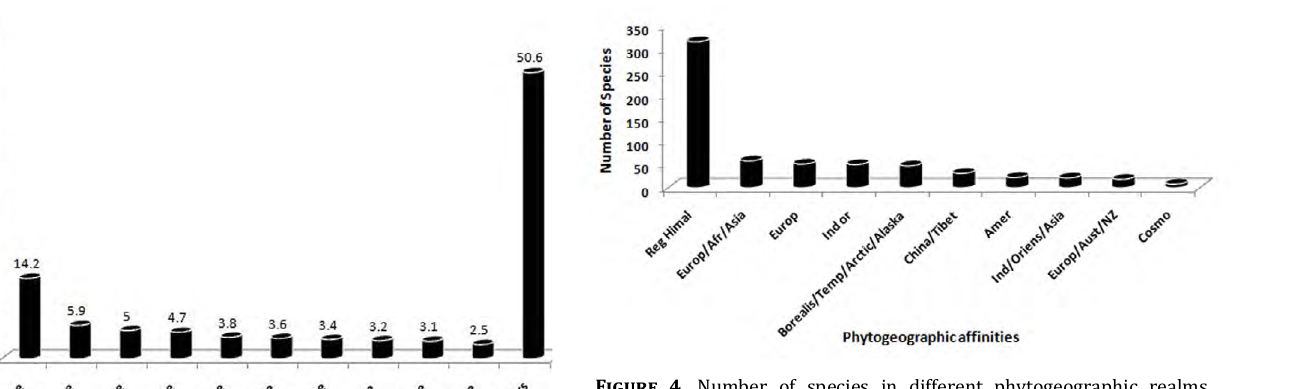
Figure 2. Family wise percentage of